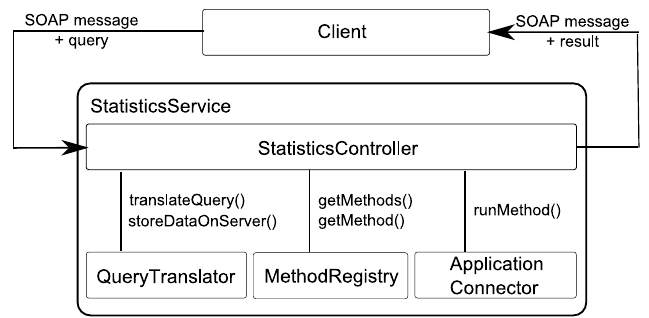
Figure 3: Query process of statistics web